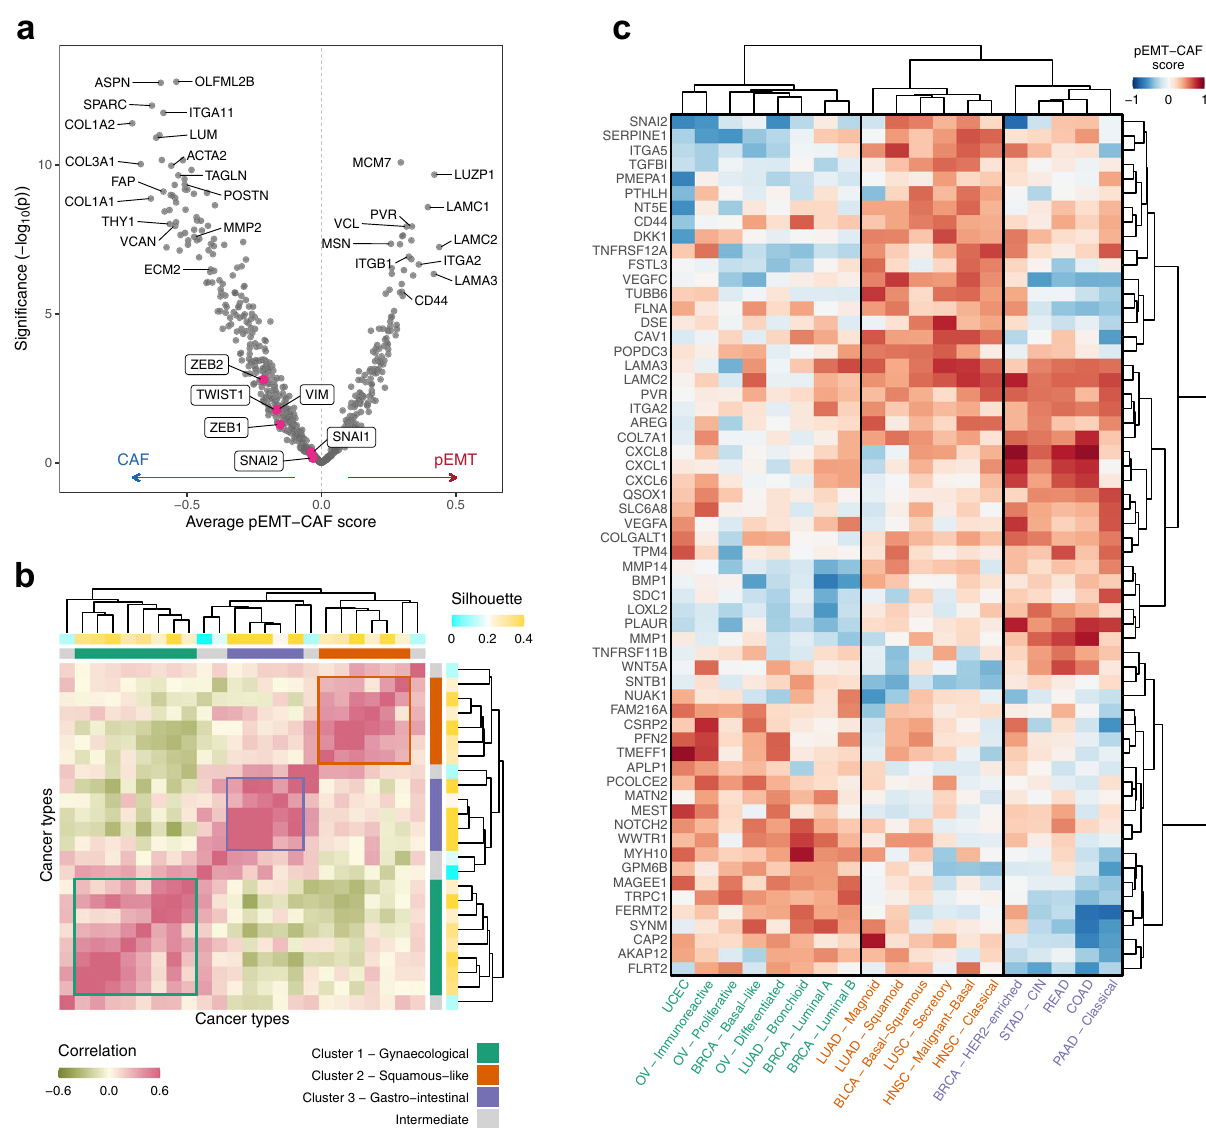
Fig. 4 Variability of ESG association with cancer cells and CAFs across cancer types/subtypes. a Volcano plot showing each gene ’ s average pEMT-CAF score (X-axis) and its signi fi cance (Y-axis, quanti fi ed as -log10(p-value) based on two-sided T-test, without adjustment for multiple comparisons). Shown are all ESGs included in the TCGA deconvolution analysis, and selected ESGs are labelled. Source data are provided as a Source Data fi le. b Heatmap showing hierarchical clustering of pairwise correlations between cancer types/subtypes based on their pEMT-CAF scores for the 100 genes most commonly appearing in the inferred pEMT signatures, annotated by two coloured bars on each axis: (1) the silhouette of each cancer type with respect to the three largest clusters; and (2) the fi nal cluster assignments after identifying intermediates. c Heatmap of pEMT-CAF scores for the top 20 differentially expressed pEMT genes in each of the three cancer type clusters. Both axes are ordered by hierarchical clustering. Source data are provided as a Source Data fi